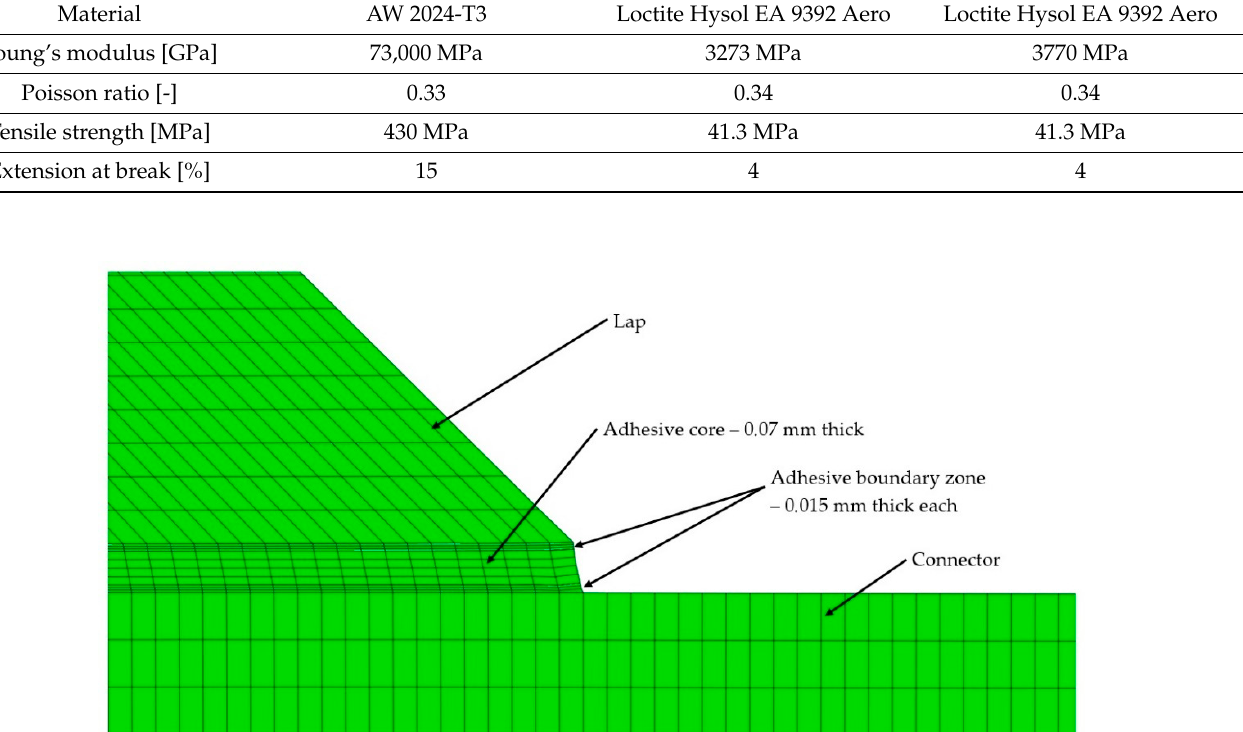
Table 1. Material properties of materials used in the FEM model. Model Body.